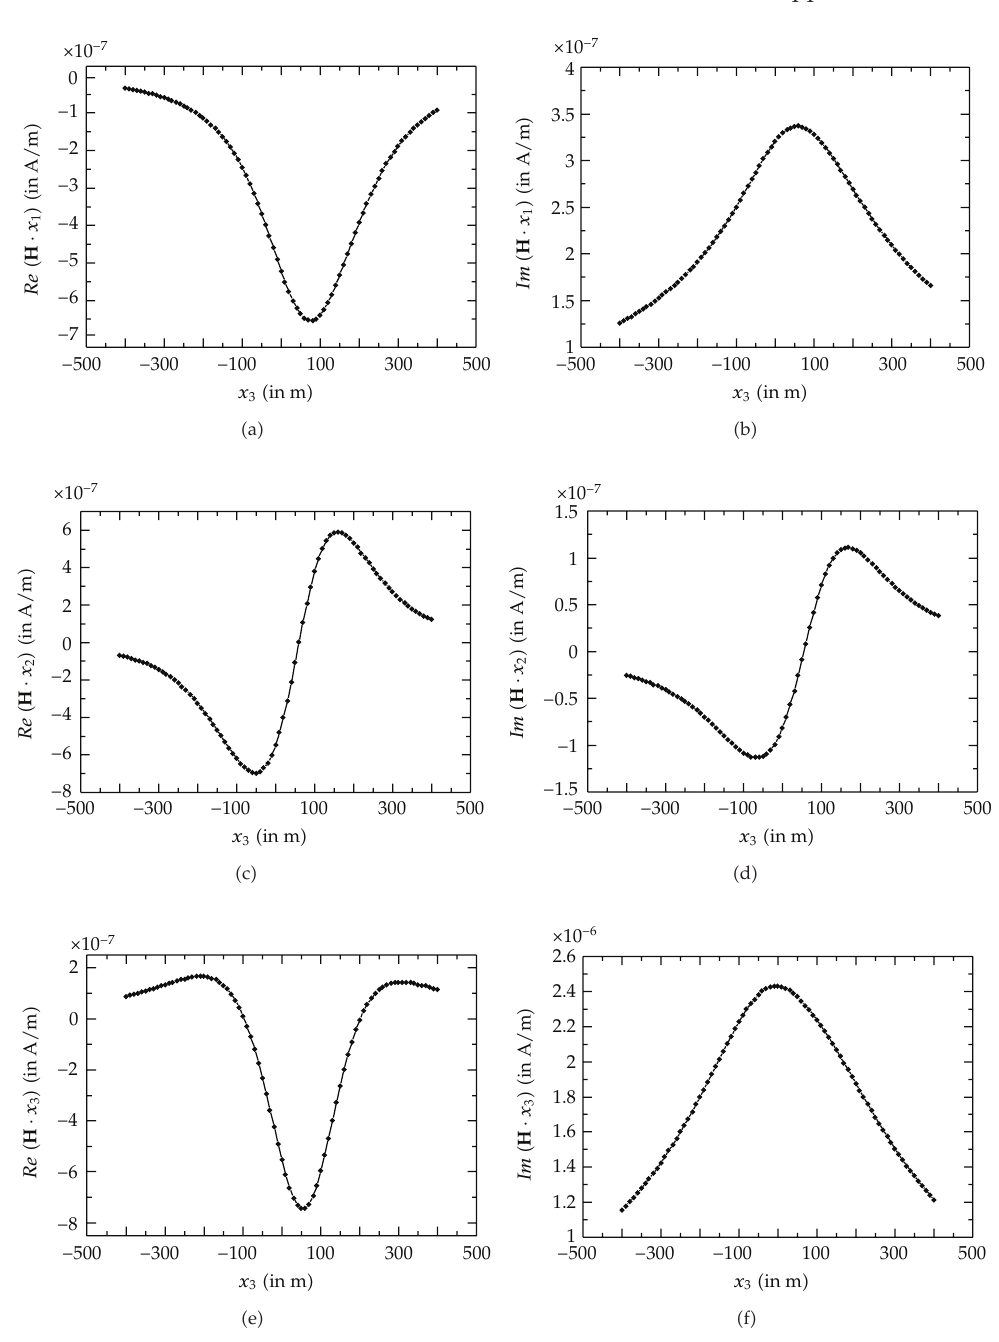
Figure 3: The real and the imaginary parts of the approximated low-frequency scattered magnetic field H for the orders n (cid:4) 0 , 2 , 3. The two spheres have di ff erent radii α 1 (cid:4) 25m and α 2 (cid:4) 50m, while their centers are at the somewhat far distance d (cid:4) 100m. The magnetic dipole is located at (cid:2) x 10 ,x 20 ,x 30 (cid:3) (cid:4) (cid:2) 200m , 0m , 0m (cid:3) and the measurement line probe is placed at (cid:2) x (cid:3) (cid:4) (cid:2) 0m , 200m , (cid:6) − 400 , 400 (cid:7) m (cid:3) , 1 p ,x 2 p ,x 3 p obtaining the field on the x 3